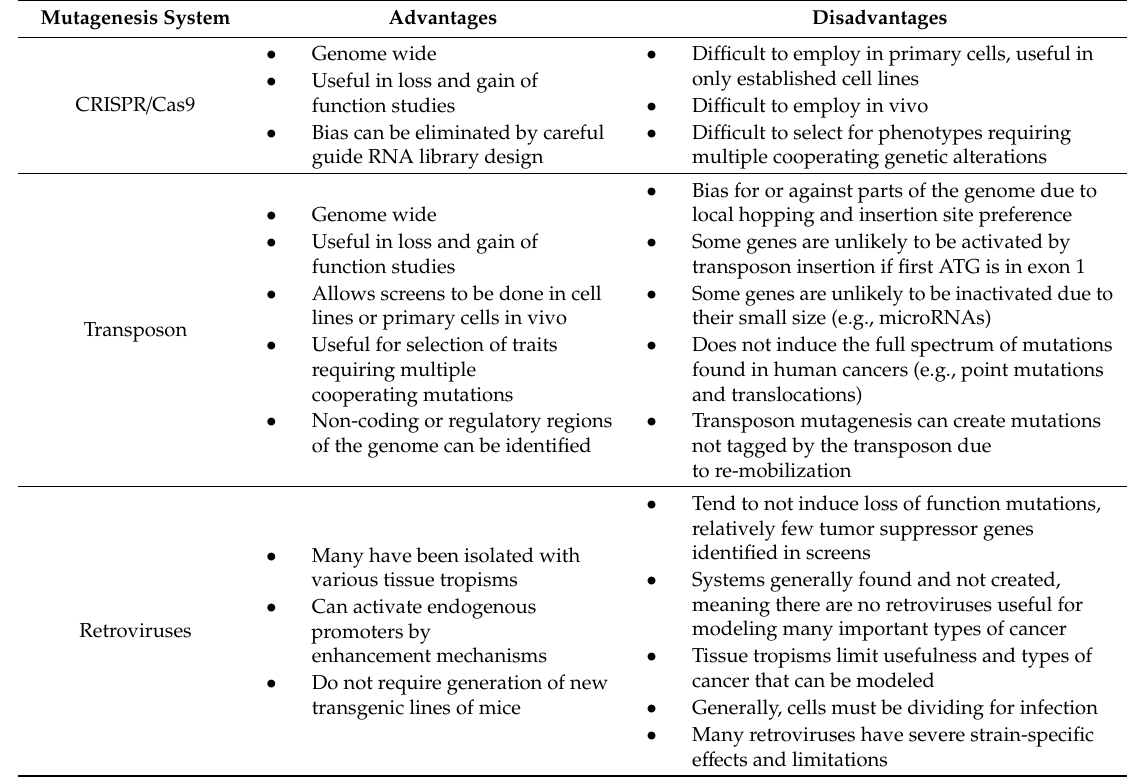
Table 1. Systems for Cancer Functional